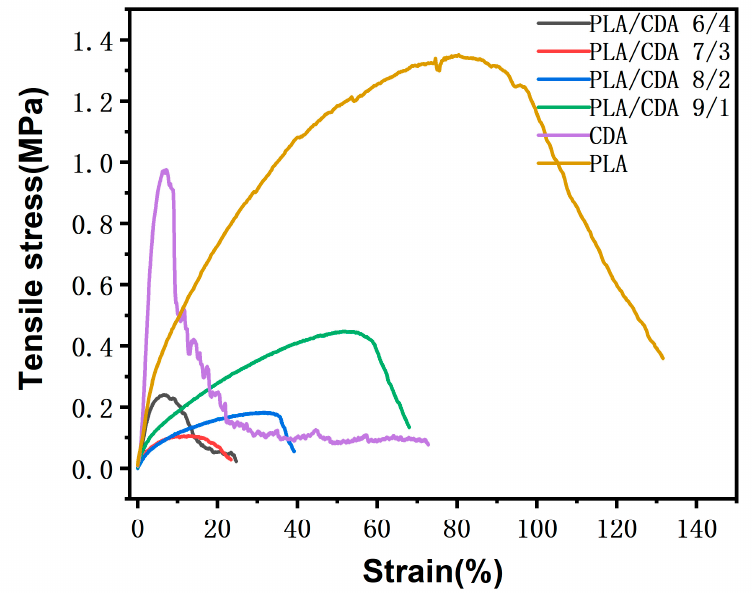
Figure 7. Stress–strain curves of pure PLA, pure CDA, and PLA/CDA mixed fiber membranes.